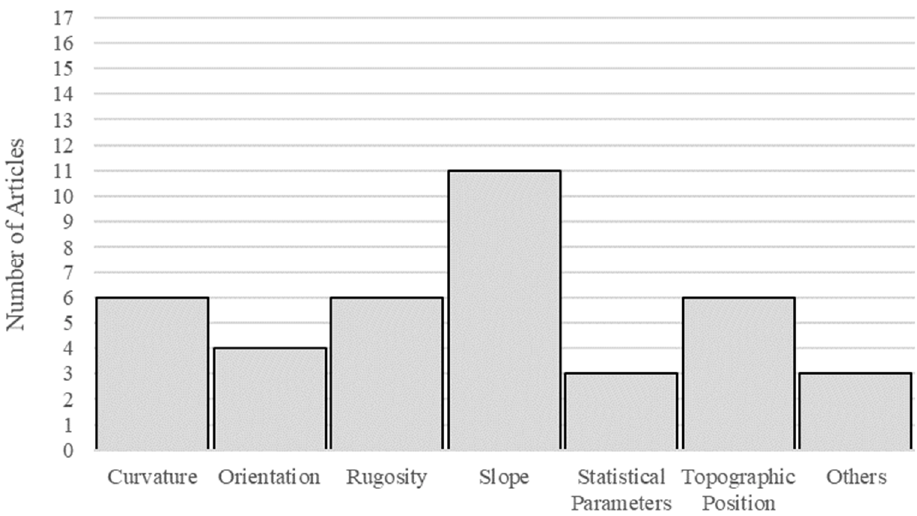
Figure 3. The categories of terrain attributes used in the articles of the special issue.